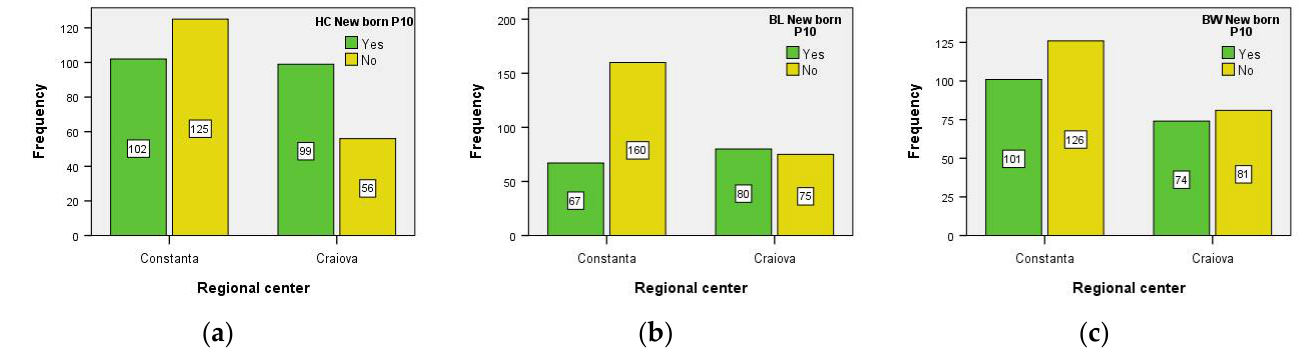
Figure 3. Anthropometric parameters ( a ) head circumference (HC), ( b ) birth length (BL), and ( c ) birth weight (BW) of HIV-negative newborns from the two Reginal Centers. P10 = percentile 10. The test does not reveal significant differences between the BL HIV-negative newborns from Constanta, RC (Median = 48.00, n = 227), and BL HIV-negative newborns from Craiova, RC (Median = 48, n = 155), U = 17269, z = − 0.308, p = 0.758. There was an association between the variables in each RC and the BL HIV-negative newborns (i.e., χ 2 stat = 18.999, df = 1, p < 0.001 < α = 0.05). The chance of finding a newborn with BL < 10th percentile present in the group of patients from Constanta, RC, is 2.54 (1/0.393) times lower than the chance of finding a newborn with BL < 10th percentile present in the group of patients from Craiova, RC: OR = 0.393; 95% CI for OR = (0.257, 0.600) (Figure